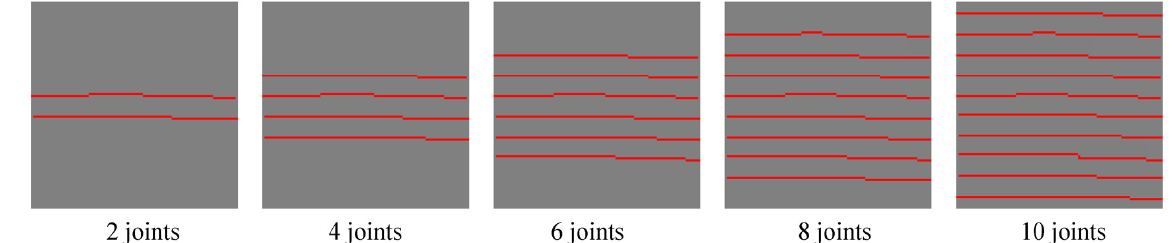
Figure 1. Rock model with different NPJs when size is 100 × 100 mm.